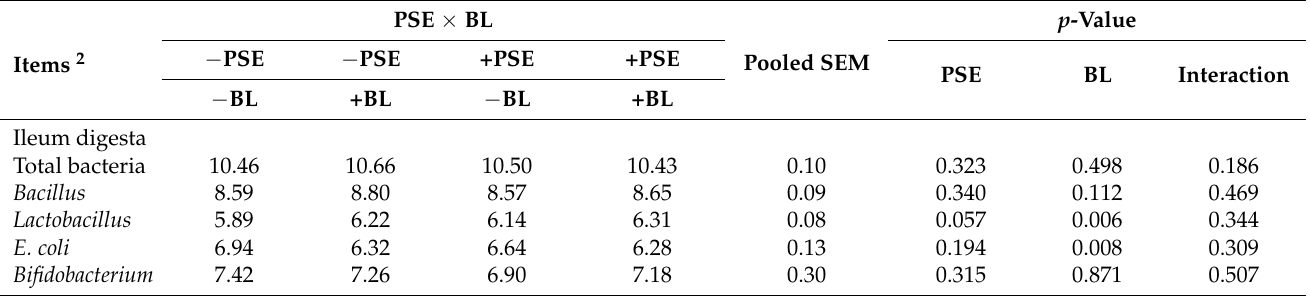
Table 3. Effects of BL and PSE on microbes in the ileal digesta of weaned piglets (10 copies/g of wet digesta) 1